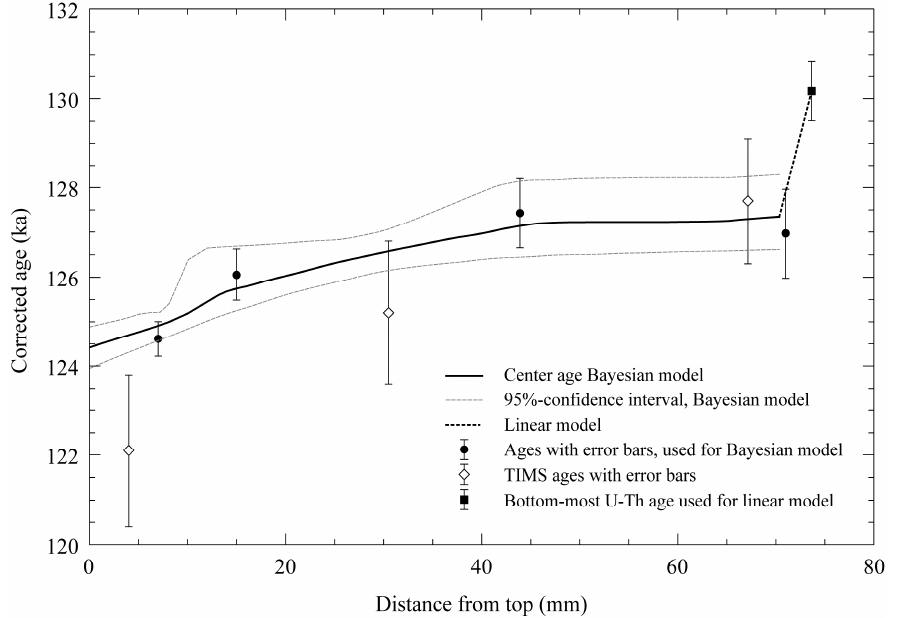
Figure 3. Bayesian age-depth model with 95% confidence interval for Kf-21 based on MC-ICPMS ages. Linear age-depth model created for bottom most part shown by dashed line. TIMS ages provide support for the created age-depth but were not included due to large uncertainties. Please note that the amount of material sampled for TIMS ages was large (see Figure 2). All U-Th ages are shown with 2 σ error bars.